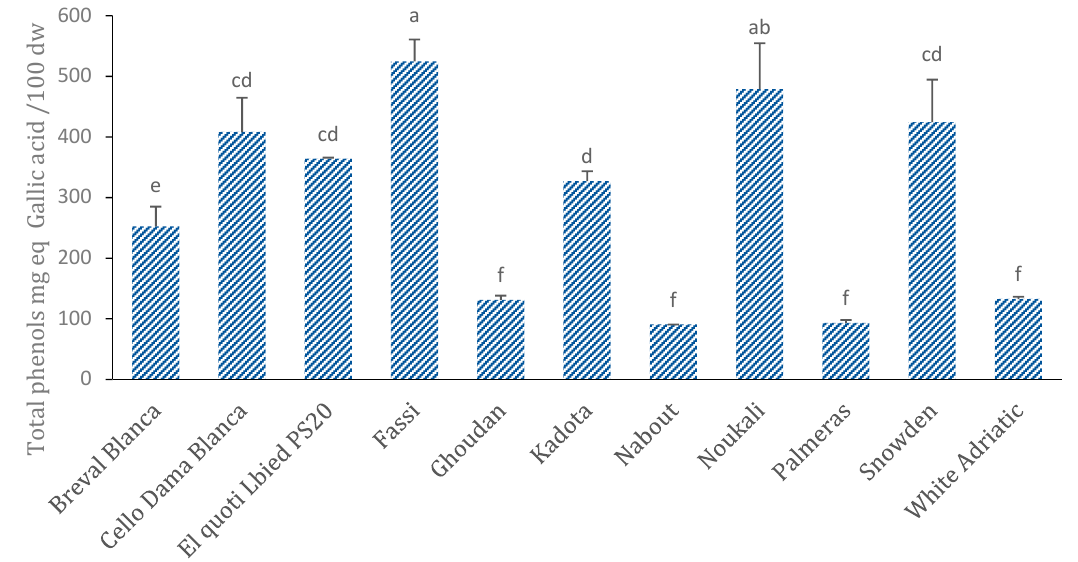
Figure 7. Total phenolic content (mean ± SE in mg GAE/100 g dw) of the whole fruit for 11 fig cultivars. Average values ± standard deviation are presented. Statistically significant differences among cultivars are presented over error bars (a–f).